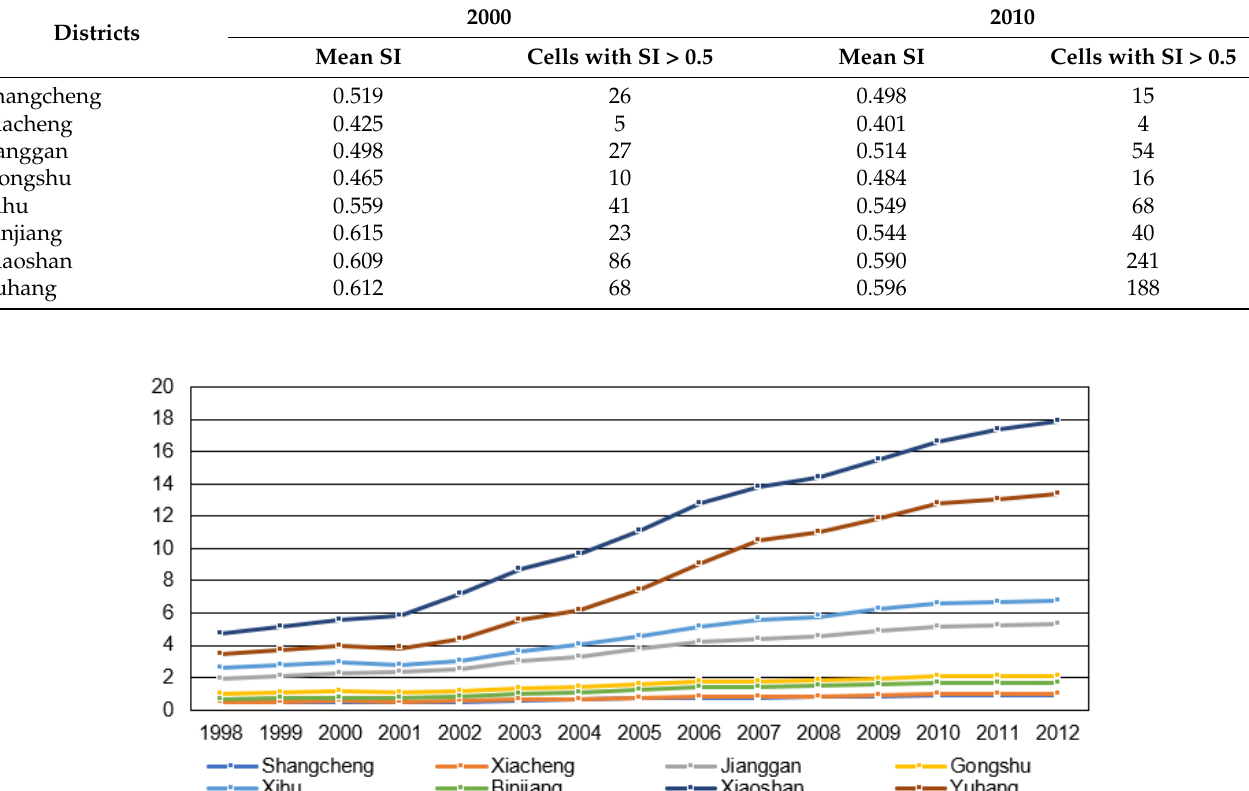
Table 4. Descriptive statistics of sprawl index on the residential land of each district.